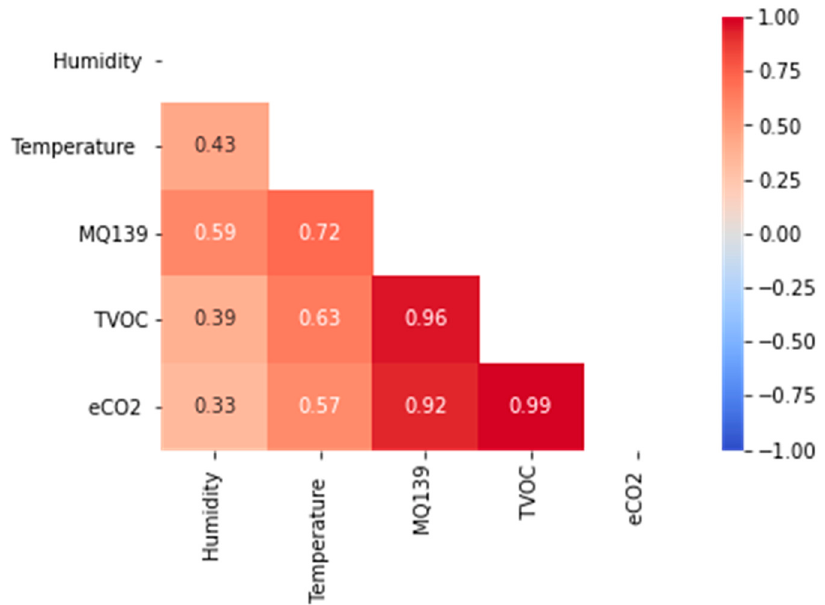
Figure 6. Both eCO 2 and TVOC are strongly correlated with MQ139. When building a machine learning predictive model, one might consider removing one of the strongly correlated features. Based on the conducted variable correlation analysis, MQ139 may be a suitable candidate for re- moval.